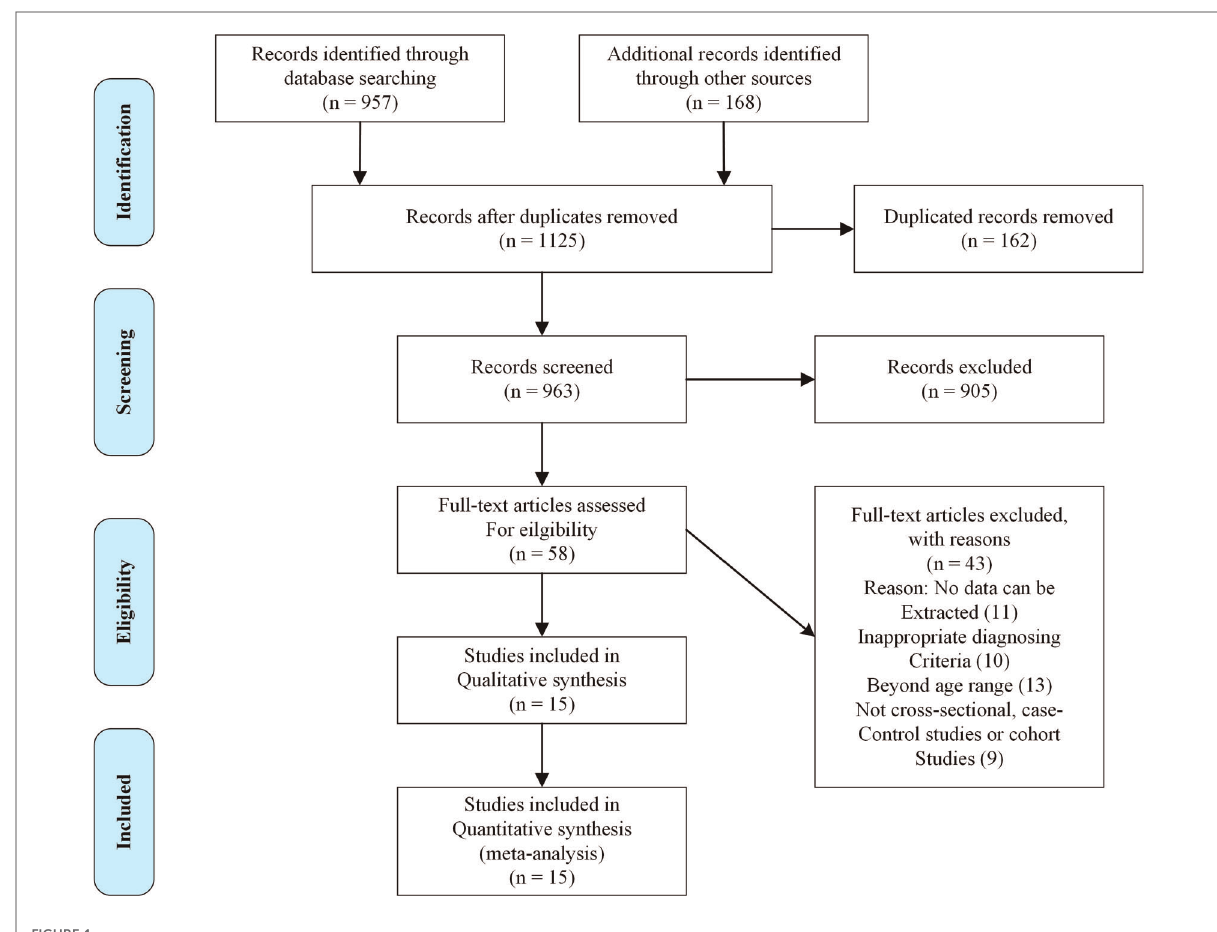
FIGURE 1 Flow chart of